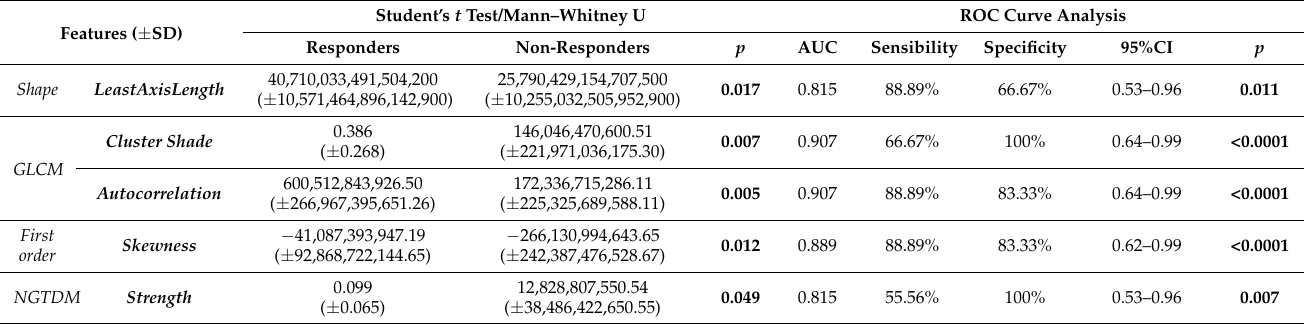
Table 3. Pre-p-ChT radiomics analysis between responders and non-responders expressed as simple comparison analysis (Student’s t test/Mann–Whitney U) and the receiver operating characteristic (ROC) curve analysis with the area under the curve (AUC), sensitivity, specificity, and interclass coefficient